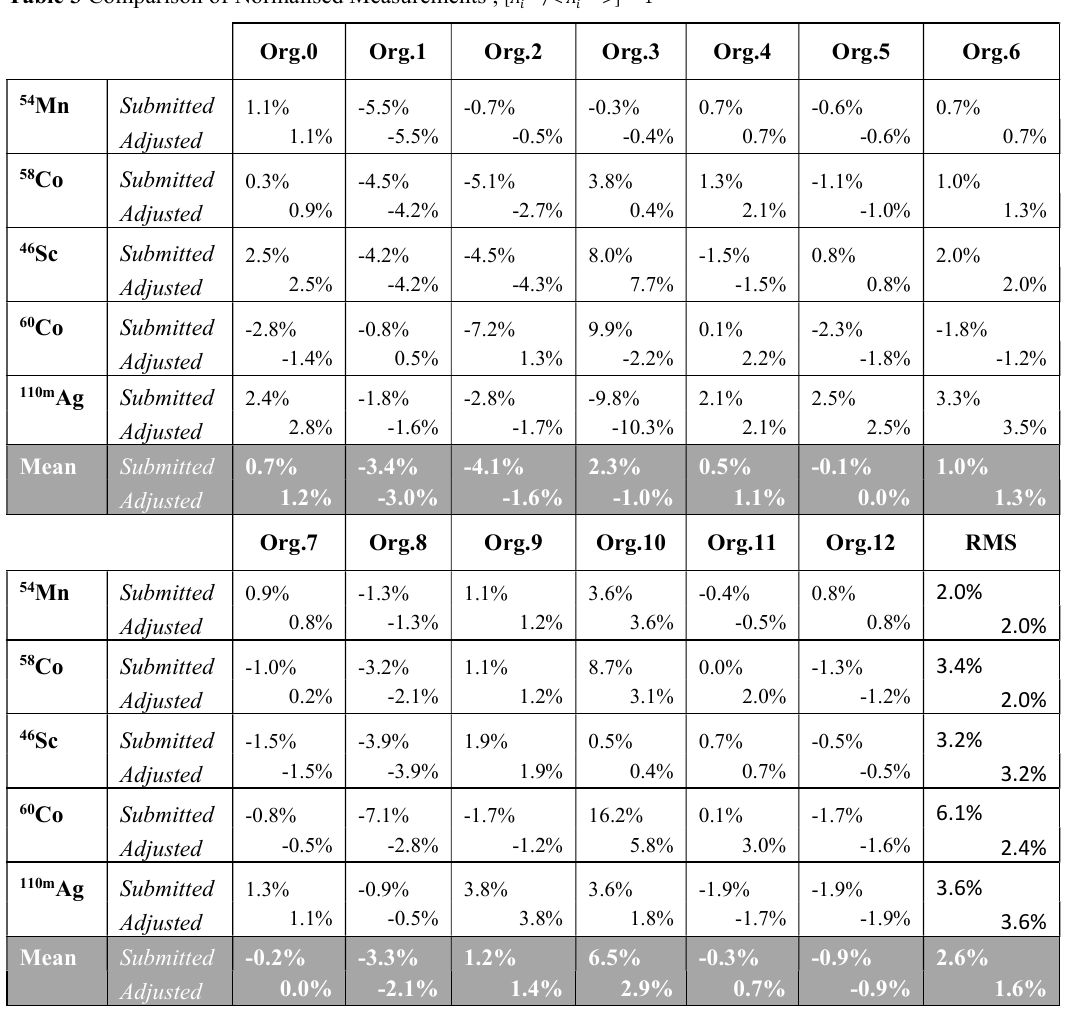
Table 3 Comparison of Normalised Measurements , [𝐴 (cid:3036)(cid:3042)(cid:3045)(cid:3034) <⁄ 𝐴 (cid:3036)(cid:3042)(cid:3045)(cid:3034) >] −